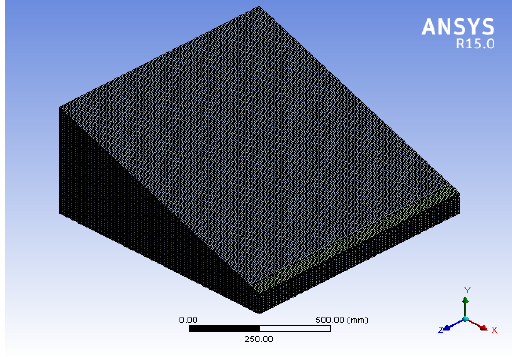
Figure 4. Meshed CFD domain of the solar still.